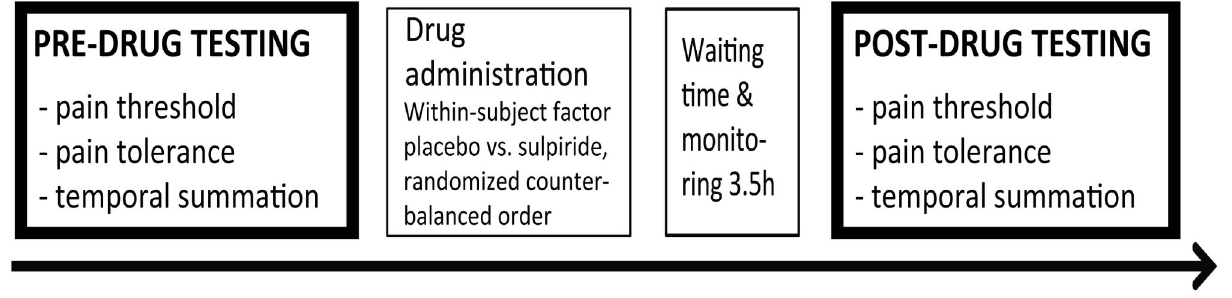
Figure 1. Overview of the time course of an experimental session of Study 1. All participants performed two sessions: in one session they ingested 600 mg sulpiride, in the other one a placebo. In each session, participants performed pre- and post-drug testing, separated by a 3.5h waiting